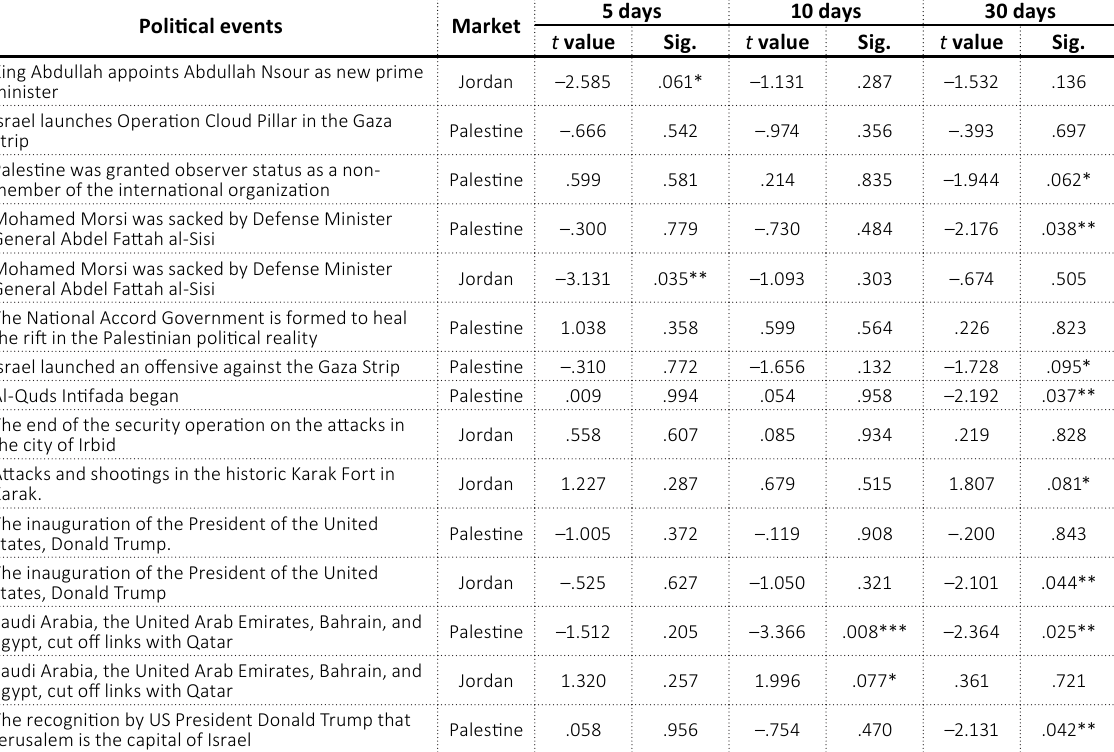
Table 8 (cont.). Paired t -test for political